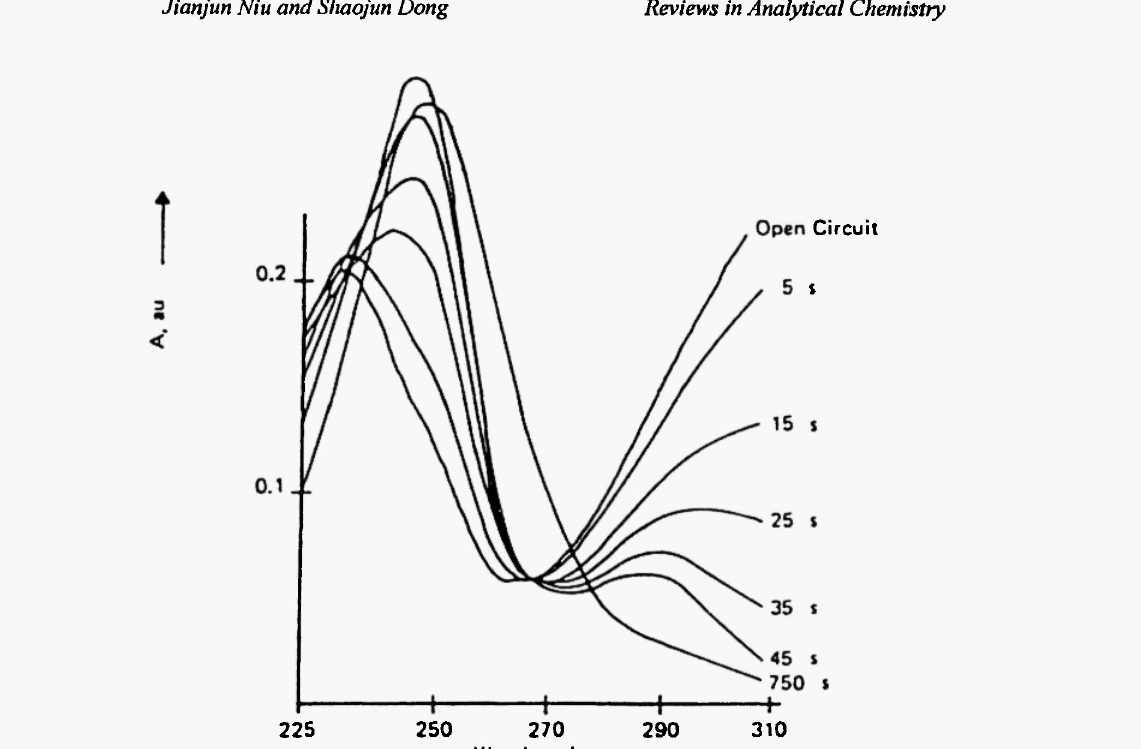
Fig. 30: Spectra recorded on Hg-Au OTTLE during single-potential-step spectroelectrochemistry. Potential from step 0.000 to -0.600 V vs. SCE. 1 mM azobenzene, 0.05 Μ HCl, 0.20 Μ KCl, 44% ethanol. Each spectrum represents 100 signal-average spectra. (From Ref.